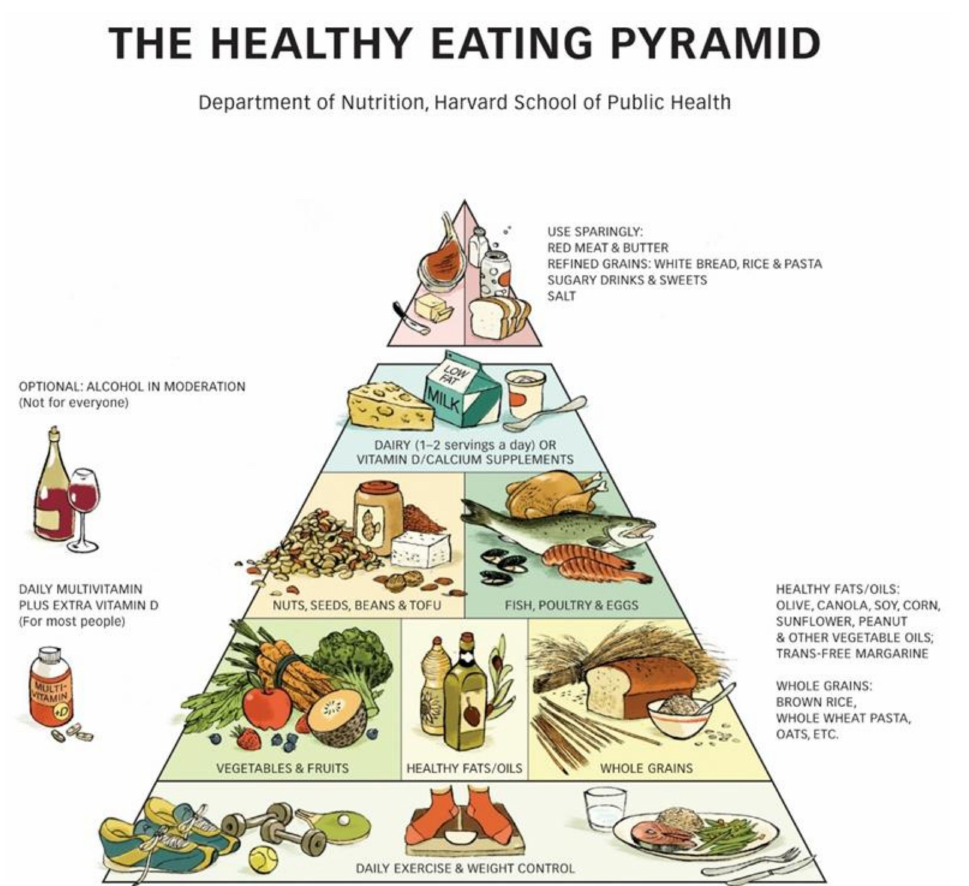
Figure 2. Harvard Dietary Pyramid [7]. Copyright © 2008. For more information about The Healthy Eating Pyramid, please see The Nutrition Source, Department of Nutrition, Harvard T.H. Chan School of Public Health, www.thenutritionsource.org (accessed on 1 February 2021), and Eat, Drink, and Be Healthy, by Walter C. Willett, M.D. and Patrick J. Skerrett (2005), Free Press/Simon & Schuster